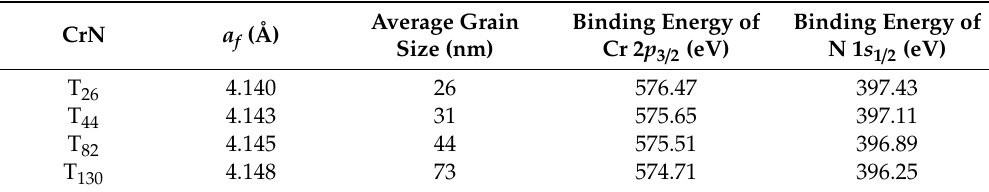
Figure 5. XPS spectra of the CrN thin films with di ff erent thicknesses: ( a ) Cr 2p and ( b ) N 1s. Table 1. The microstructure and binding energy parameters of CrN thin films. (Lattice constant of the CrN thin film a f